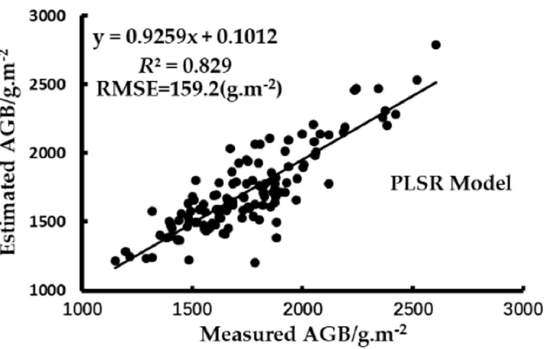
Figure 14. The fitting results of vegetation index and AGB based on UAV in the post-heading stage.